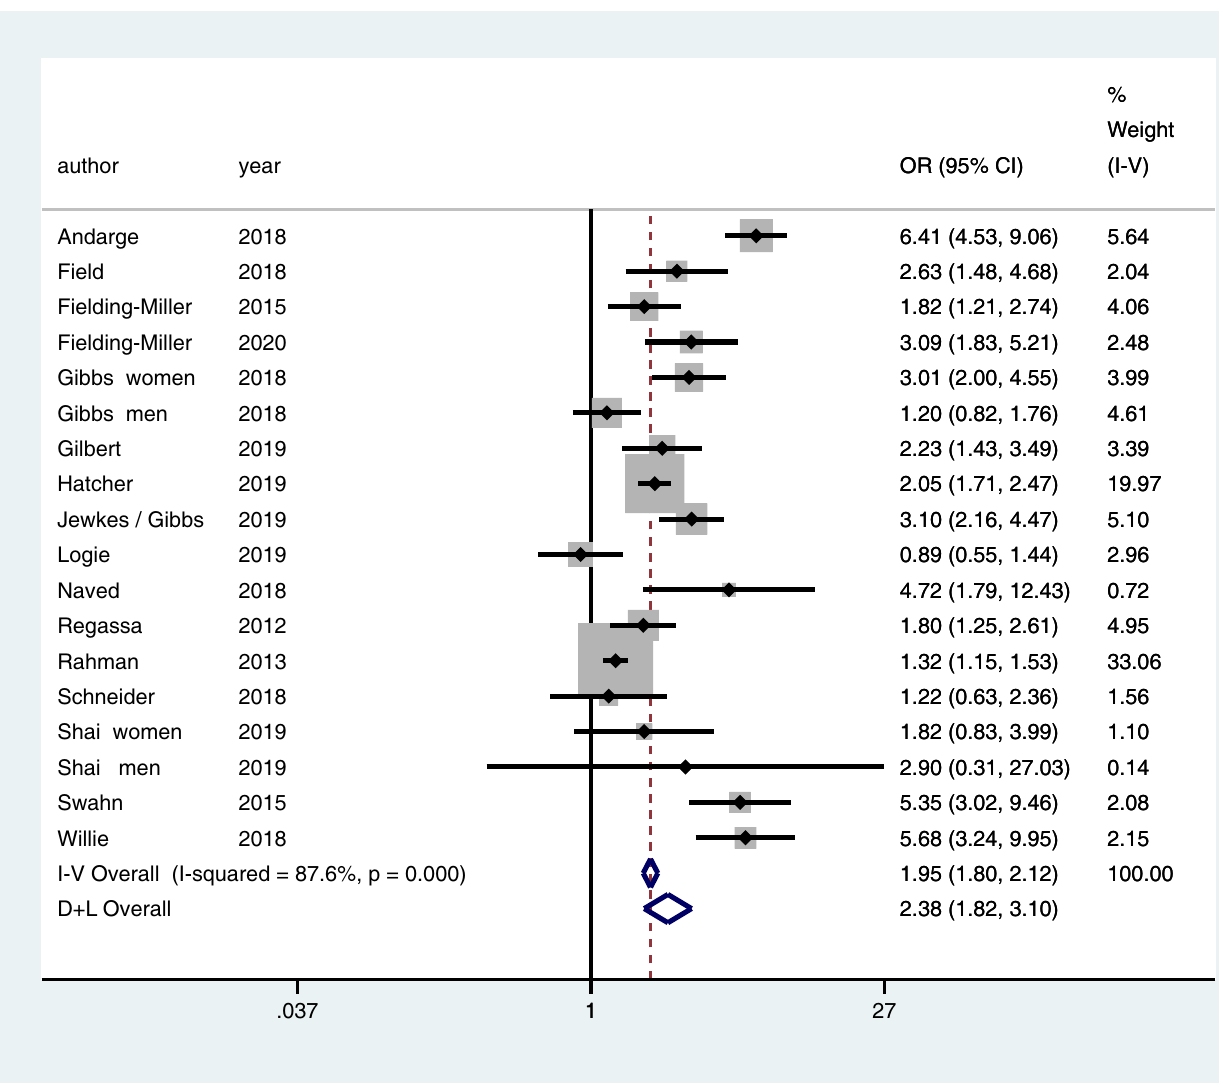
I-V Overall (I-squared = 87.6%, p =